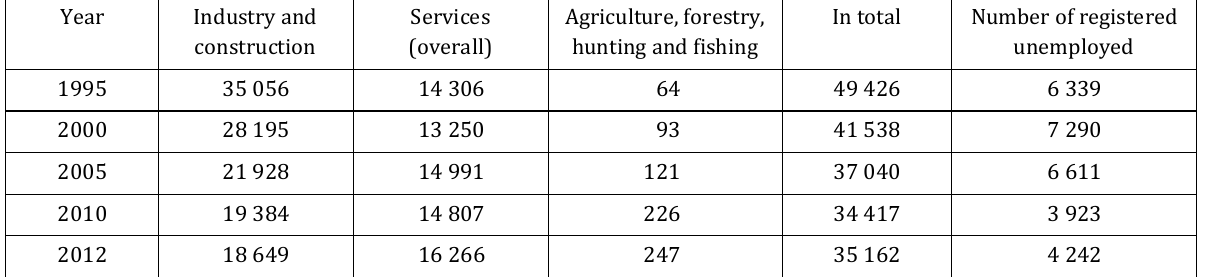
Table 1. Employment by sectors of the economy (by Rocznik statystyczny, 1995; www.stat.gov.pl/gus, 1995-2012) Year Industry and Services Agriculture, forestry, In total Number of registered construction (overall) hunting and fishing